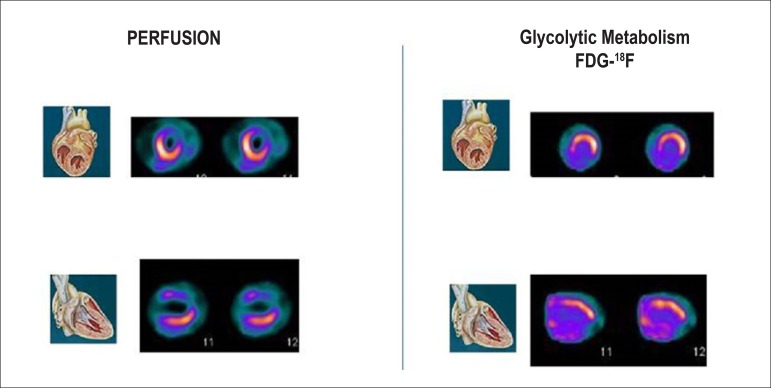
Patient with cardiac sarcoidosis. Myocardial perfusion scintigraphy (MPS) with MIBI-99mTc (left), showing evidence of accentuated persistent hypoperfusion in the anterior and anterolateral walls of the left ventricle; FDG-18F - PET imaging (right) for metabolic study shows that regions with apparent fibrosis were in fact inflammation due to sarcoidosis.